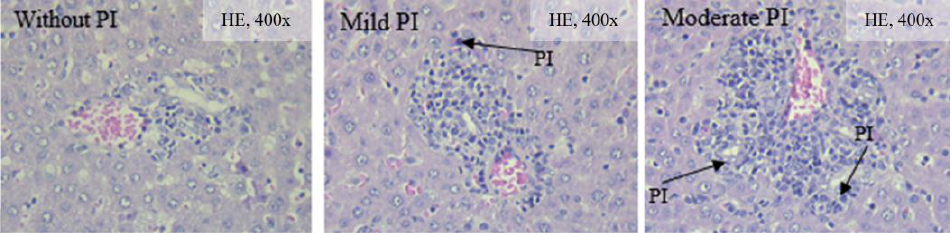
Figure 4. Histological section of portal triad in liver tissue stained with HE magnification 400x. Among untreated group, the mosquito smoke showed higher average of METAVIR score which indicate severe portal infalmation (PI). The PI was higher in cigarette and mosquito smoke among treated and untreated